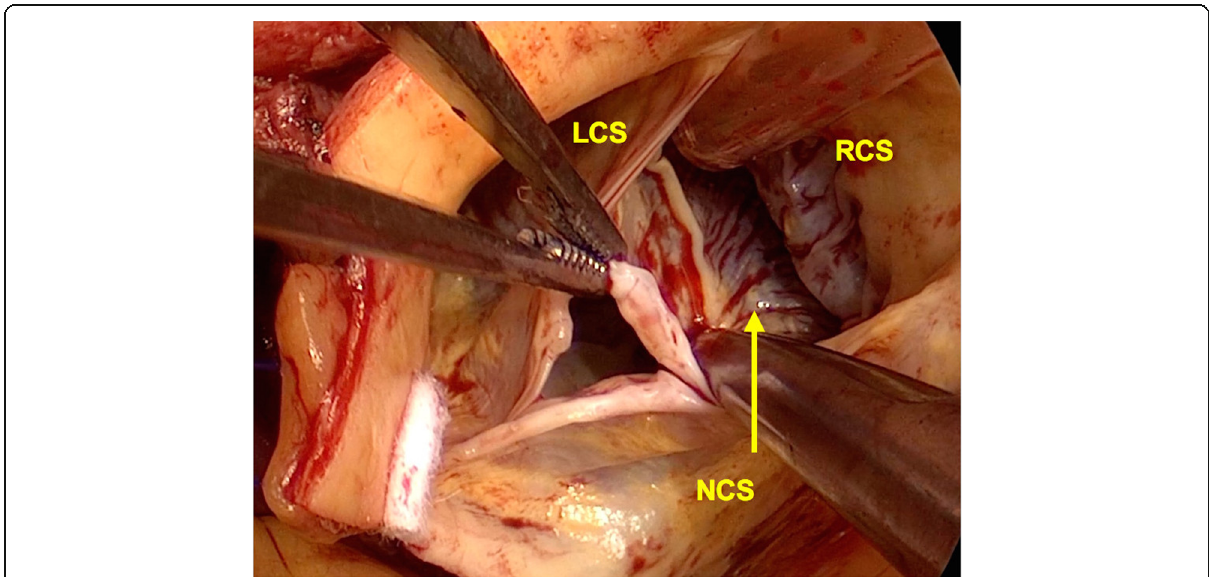
Fig. 3 Intraoperative view showing the orifice of the right sinus of Valsalva aneurysm. The aortic wall at the annulus is also lost, and the ventricular muscles are observed (arrow). LCS, left coronary sinus; RCS, right coronary sinus; NCS, noncoronary